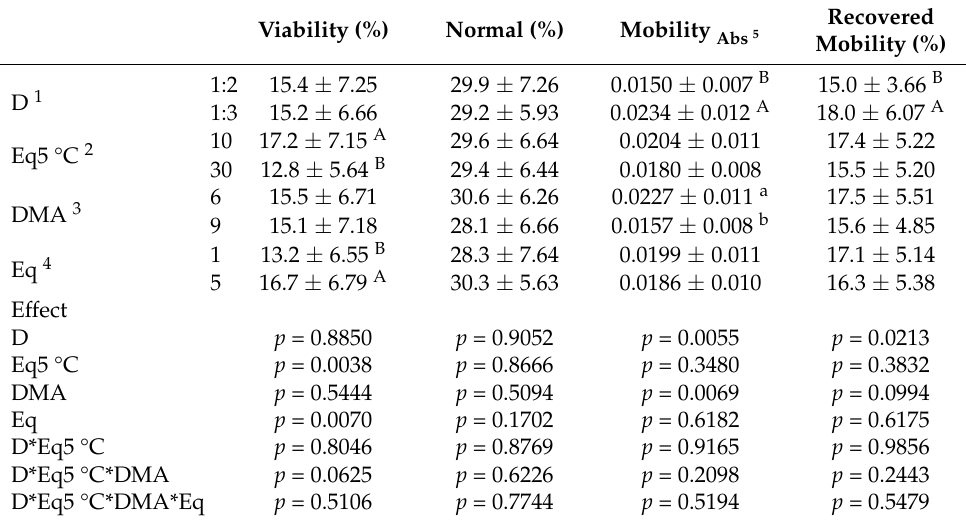
Recovered Abs 5 Mobility (%)